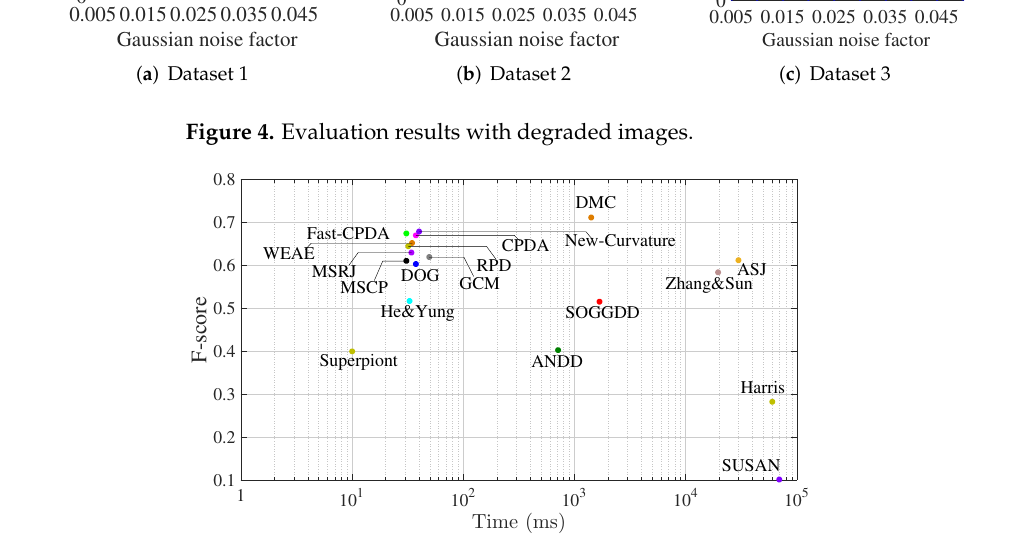
Figure 5. Comprehensive performance in terms of average running times and F scores of different algorithms on Urban_corner